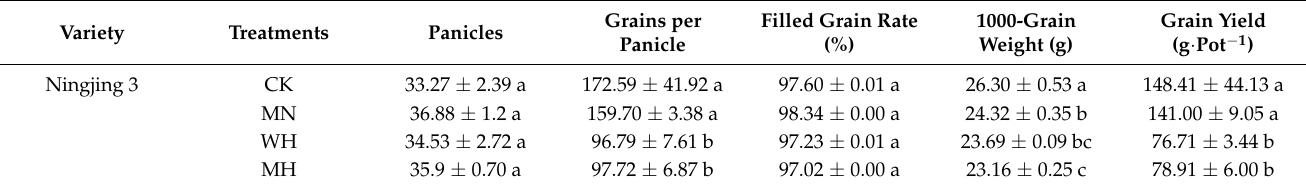
Table 2. Effects of exogenous MeJA on rice yields and yield components under high